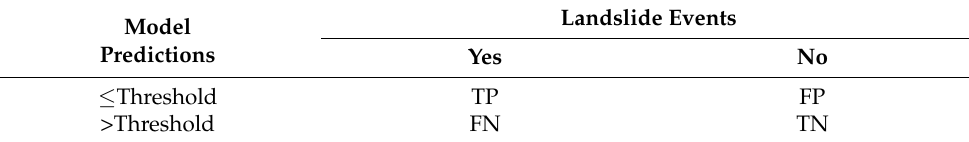
Table 1. Contingency table.